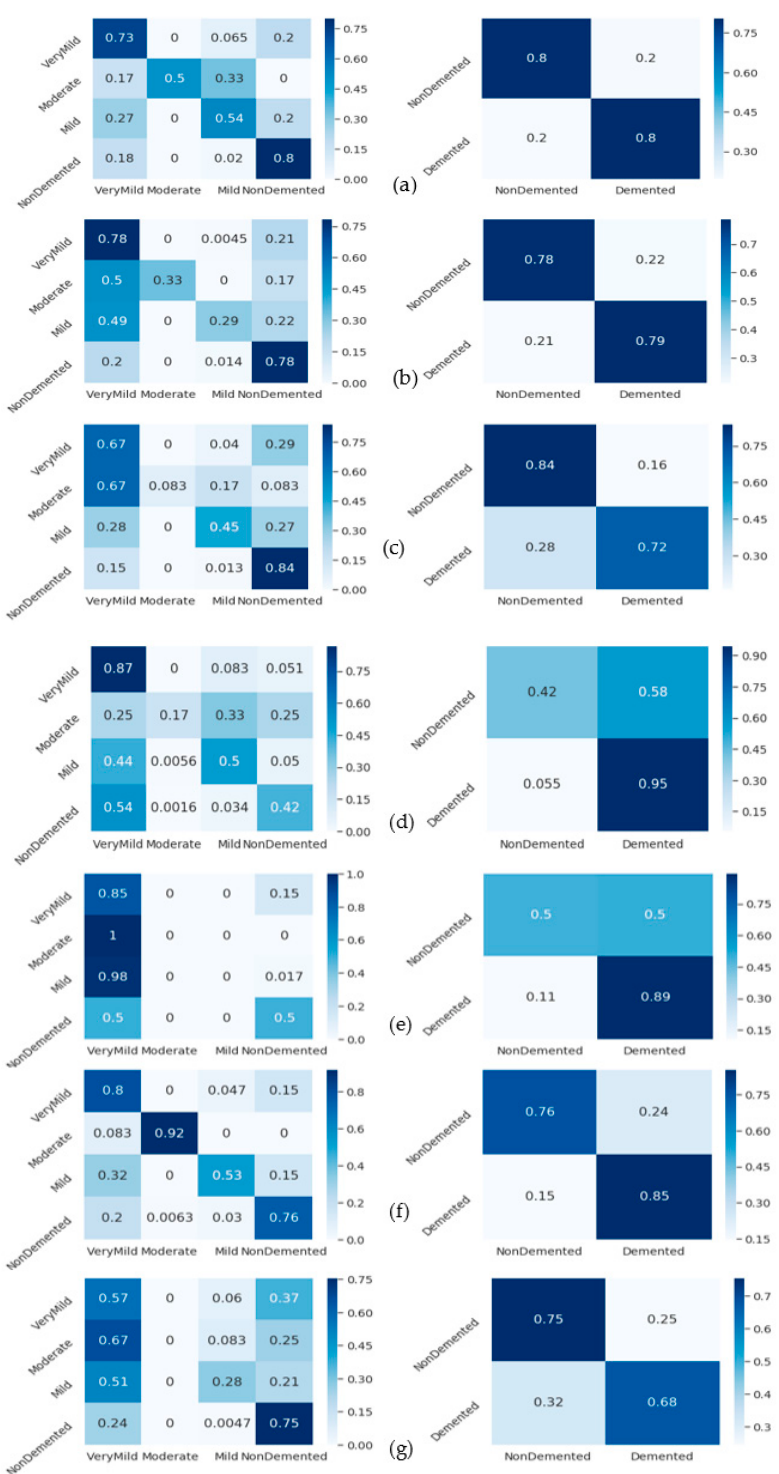
Figure 8. An example of confusion matrix for state-of-the-art systems to recognize four stages of AD such as non-demented, mild dementia, moderate dementia, and very mild dementia. Where ( a ) shows Murugan-DEMNET-CNN [15], ( b ) represents Mehmood-Siamese-CNN [16], ( c ) presents Islam-Deep-CNN [17], ( d ) shows Janghel-VGG16-SVM [19], ( e ) represents Talo-ResNet-50 [21], ( f ) shows Gunawardena-CNN-SVM [23], and ( g ) shows Wang-CNN-Maxpool [26] systems.